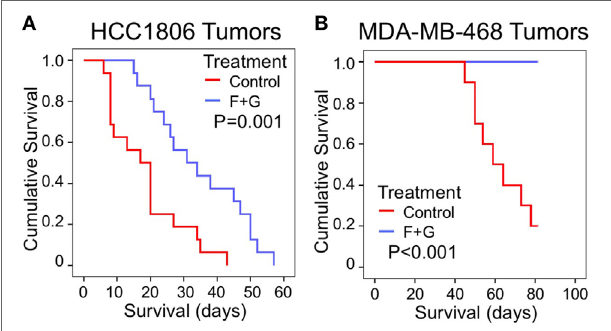
FigUre 1 | The effect of combination (fingolimod + gefitinib) treatment on the survival of nude mice bearing human xenograft TNBC tumors. (a,B) Kaplan–Meier survival curves compare the effect of control (no treatment) or combination fingolimod + gefitinib (F + G) therapy on survival of mice bearing HCC1806 (a) or MDA-MB-468 (B) xenograft tumors. For ethical reasons mouse survival is defined as tumor size below 1,000 mm 3 . For HCC1806, control: n = 16; combination: n = 16. For MDA-MB-468, control: n = 10; combination: n = 10.